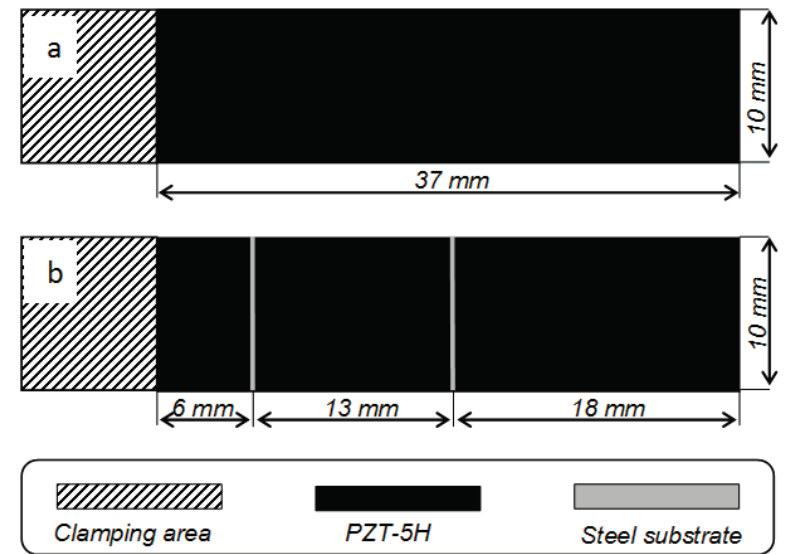
Figure 3. Schemes of elaborated piezoelectric energy harvester prototypes: ( a ) non-segmented; ( b ) segmented for operation in the third vibration